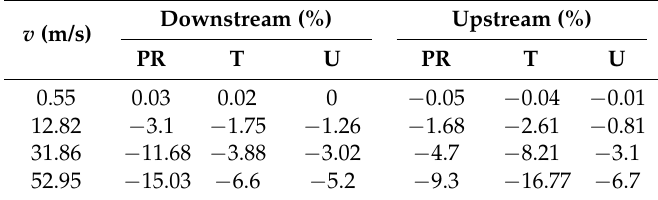
Table 1. Relative deviation of the sound pressure level on the receiver.